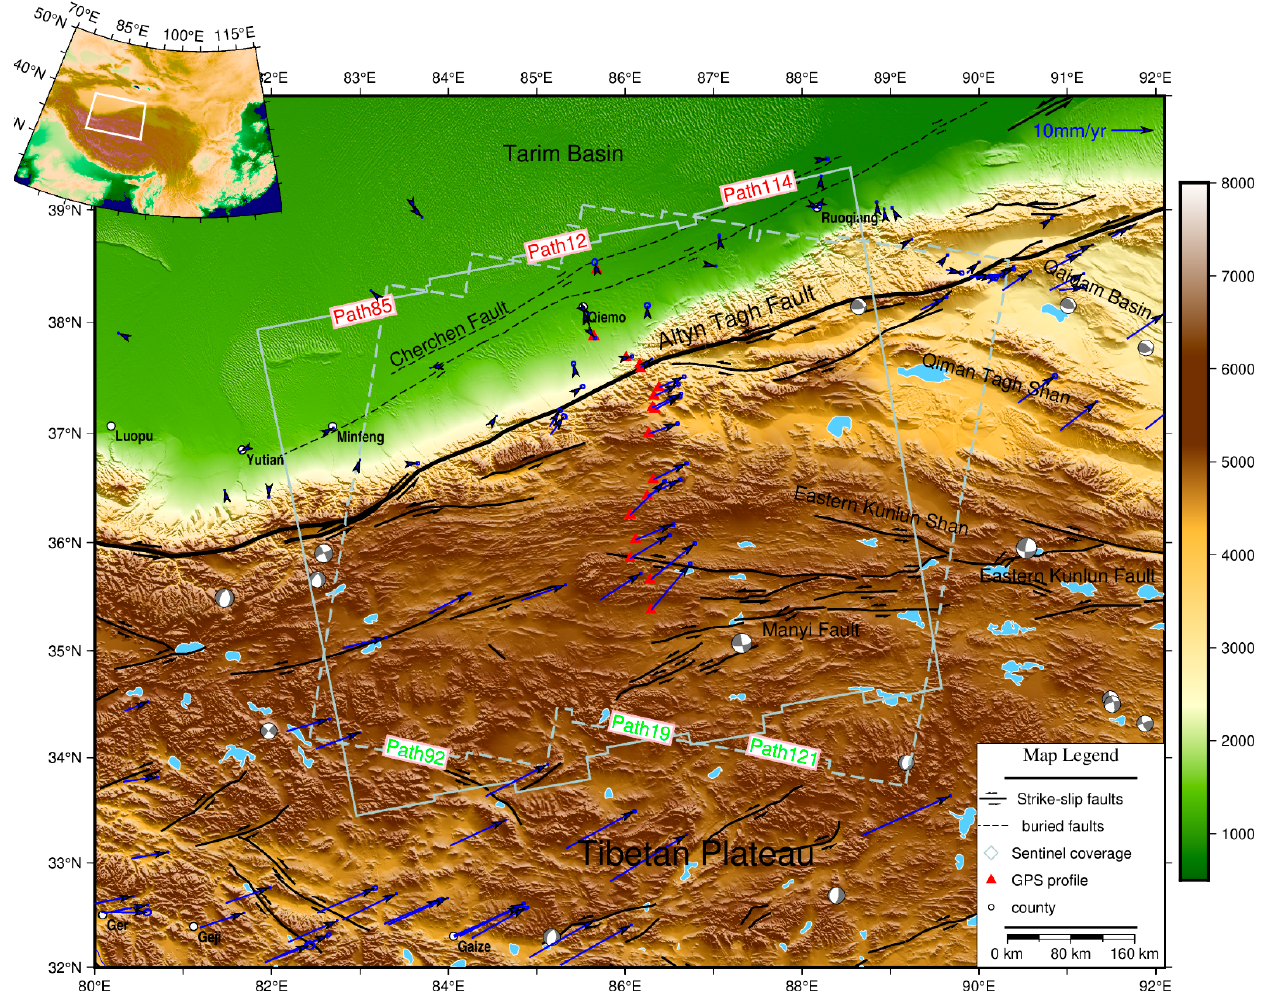
Figure 1. Tectonic map of northern Tibet showing major faults, sutures, and InSAR data coverage. It shows major faults (dashed line denoting buried faults, strike-slip faults in black). Cyan and dashed cyan rectangles show the spatial extent of the ascending and descending Sentinel-1 images, respec- tively. Beach balls in gray displaying the focal mechanisms are from the global CMT catalog